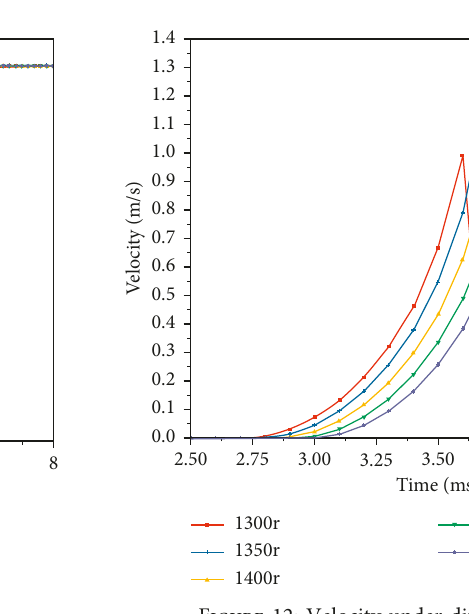
Figure 11: Current under different coil turns. Figure 12: Velocity under different coil